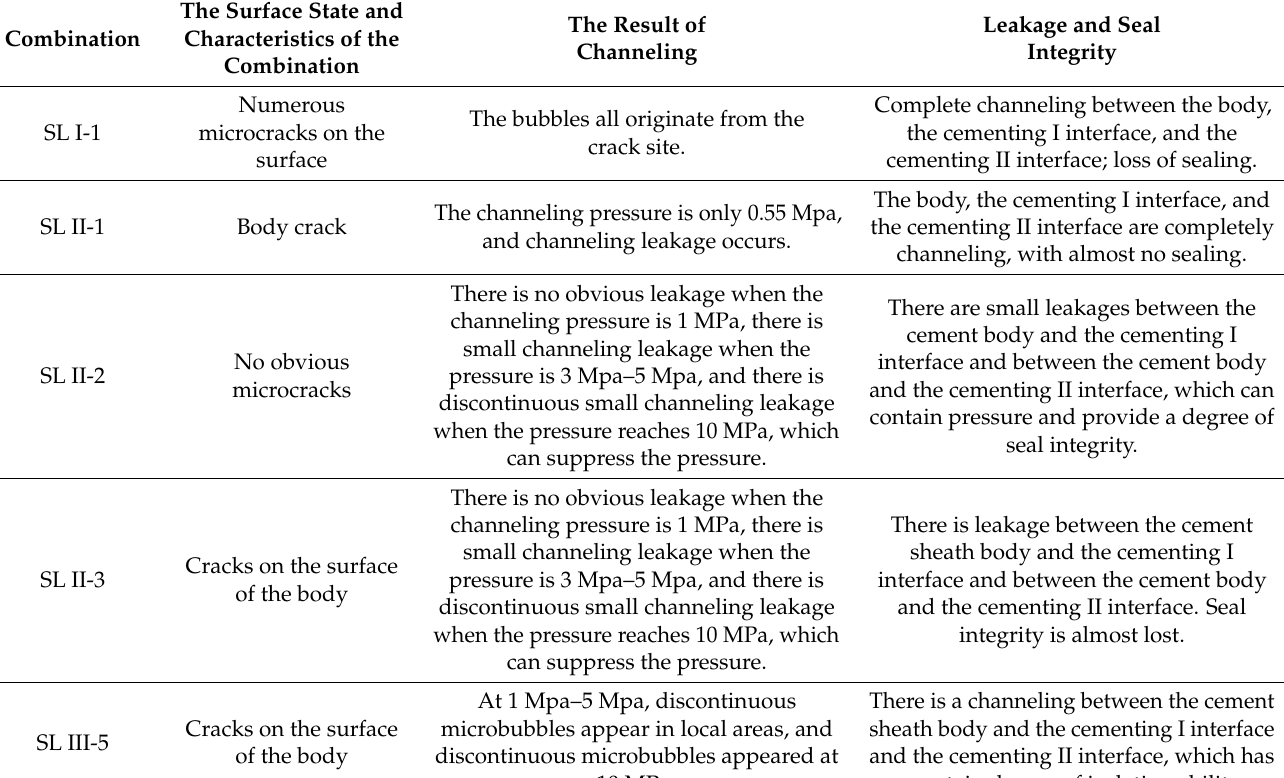
Table 2. Five cement sheath seal integrity test